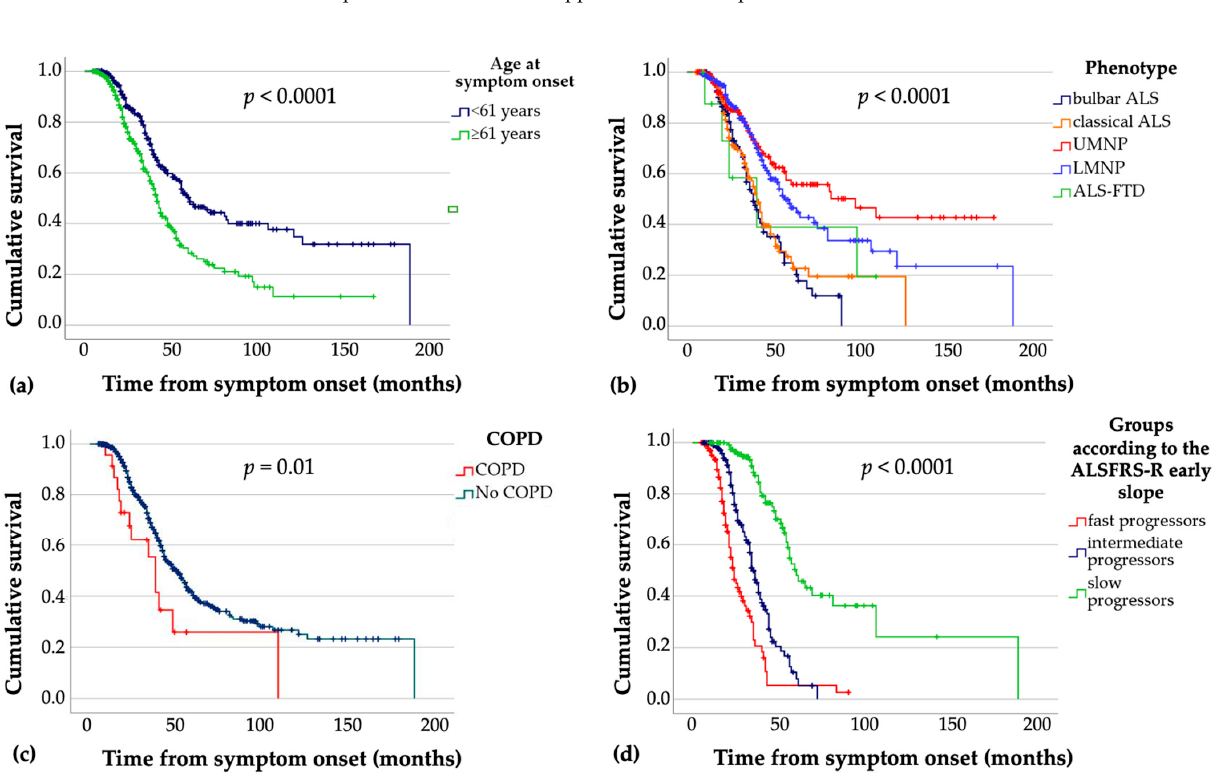
Figure 3. Kaplan–Meier survival curves according to ( a ) age at symptom onset; ( b ) clinical phenotype; ( c ) comorbid COPD; ( d ) ALSFRS-R early slope. ALSFRS-R = revised ALS Functional Rating Scale; ALS-FTD = ALS with frontotemporal dementia; COPD = chronic obstructive pulmonary disease; LMNP = lower motor neuron predominant; UMNP = upper motor neuron predominant. p values refer to the overall pooled log-rank (Mantel Cox) test.